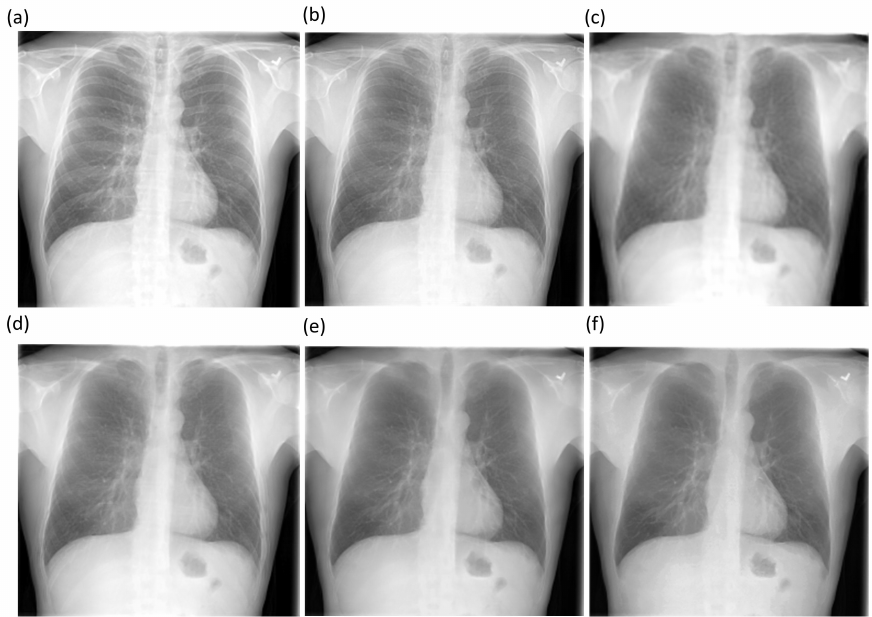
Figure 5. Bone-suppressed CXR images predicted by the proposed models using a CXR sample from the cross-institutional NIH–CC DES test set. ( a ) Original CXR; ( b ) AE–BS model; ( c ) ConvNet–BS model; ( d ) RL–BS model; ( e ) ResNet–BS model; and ( f ) Ground truth.